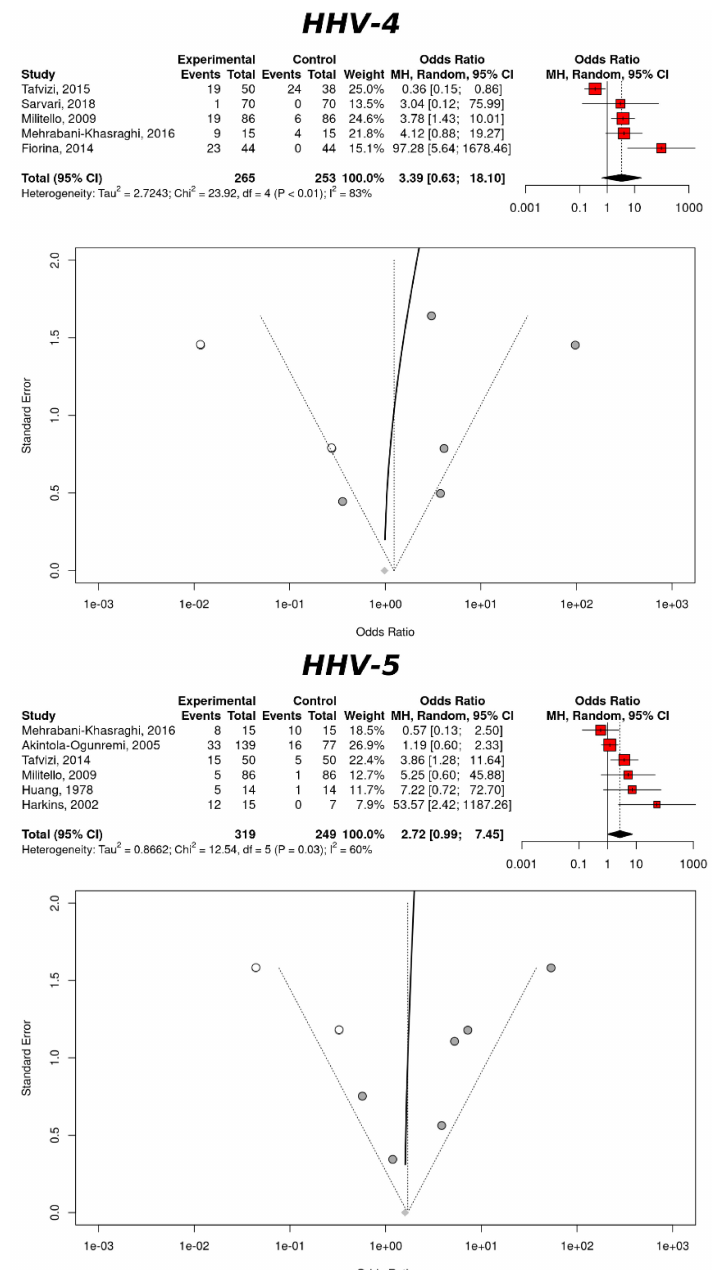
Figure 3. CRC risk and an infection with Herpesviruses, based on the colorectal tissues. The upper panel refers to HHV-4 (Epstein–Barr virus) and the lower panel refer to HHV-5 (Cytomegalovirus). Each panel includes a forest plot, based the random effects models and a funnel plot with a regression line. The studies added by the trim-and-fill method are represented by white